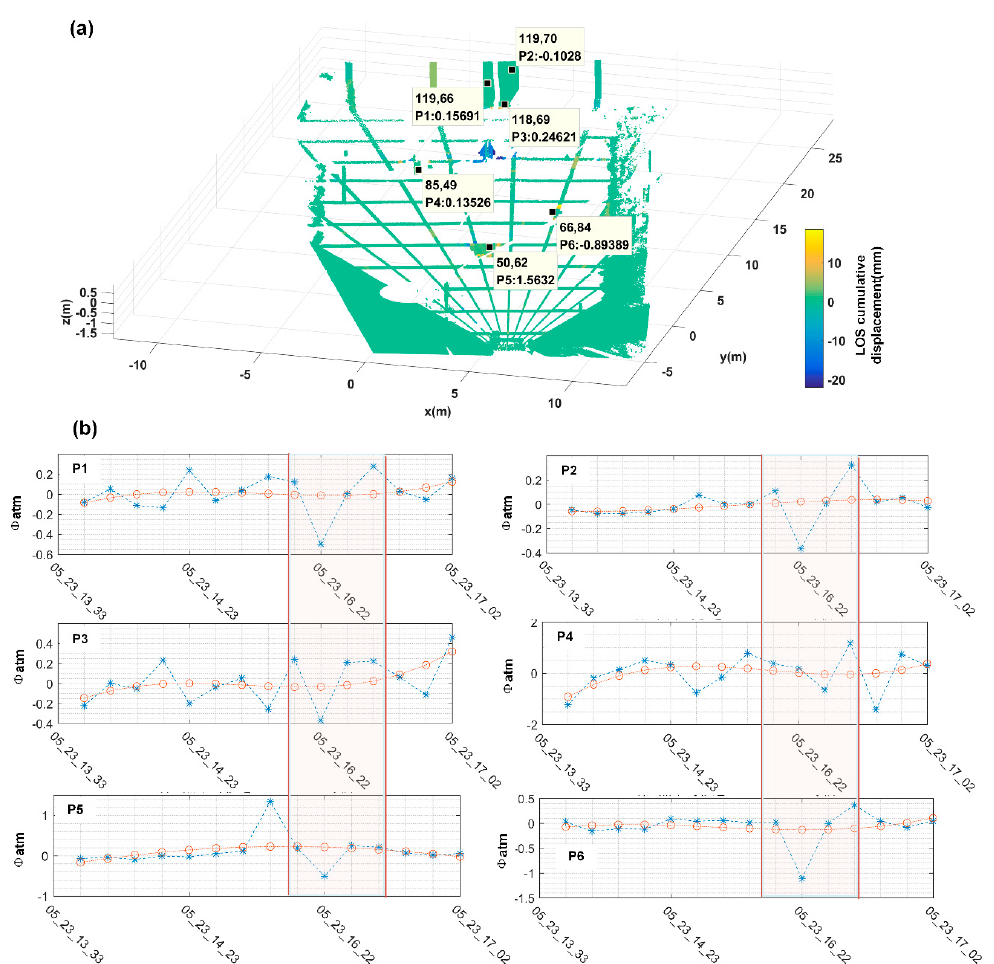
Figure 20. ( a ) For the GCP points selected based on the DA < 0.1 and only on the artificial target, there are 6 in total, among which the displacement of P5 points is artificially shifted at a certain moment. ( b ) In the red color frame, it was found that each GCP point had a strong correlation, and the atmospheric disturbance occurred during this period was comprehensively determined. The farther away from GB-SAR, the more severe the target disturbance, indicating that the atmospheric disturbance in the small region was more consistent, and it could be considered that it changed linearly with distance.